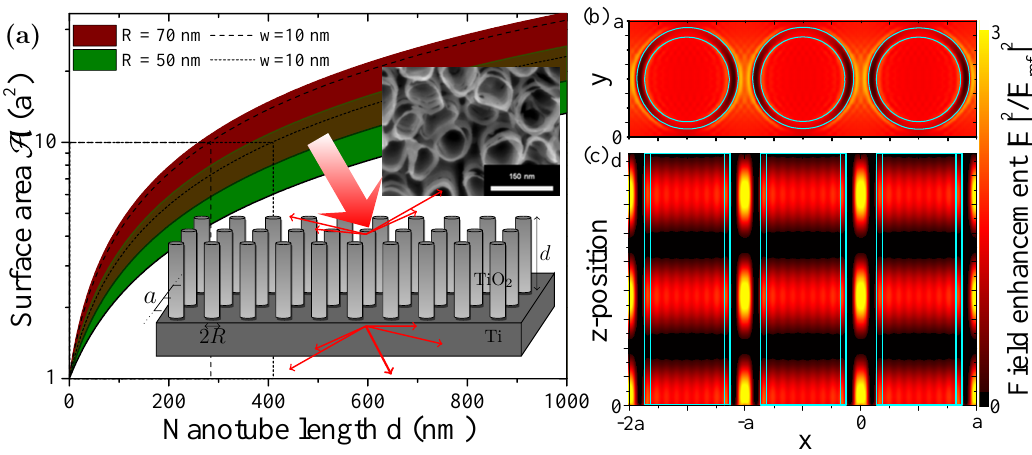
Figure 1. ( a ) Increase in surface area as a function of nanotube length d for two different outer radii R and lattice period a = 160 nm. The shaded areas span the minimum to maximum achievable surface area from solid nanopillars (wall thickness w = R ) to ultrathin walls w → 0, the dashed lines mark w = 10 nm. Insets: SEM image of real geometry after self-assembly of hollow TiO 2 nanotubes on a Ti substrate [4] and illustration of the idealized structure used in our modeling; ( b , c ) Field enhancement of a d = 500 nm NT with R = 70 nm for three neighboring unit cells ( b ) at the top of the NTs z = d and ( c ) in the orthogonal plane in the center of the unit cell at y = a